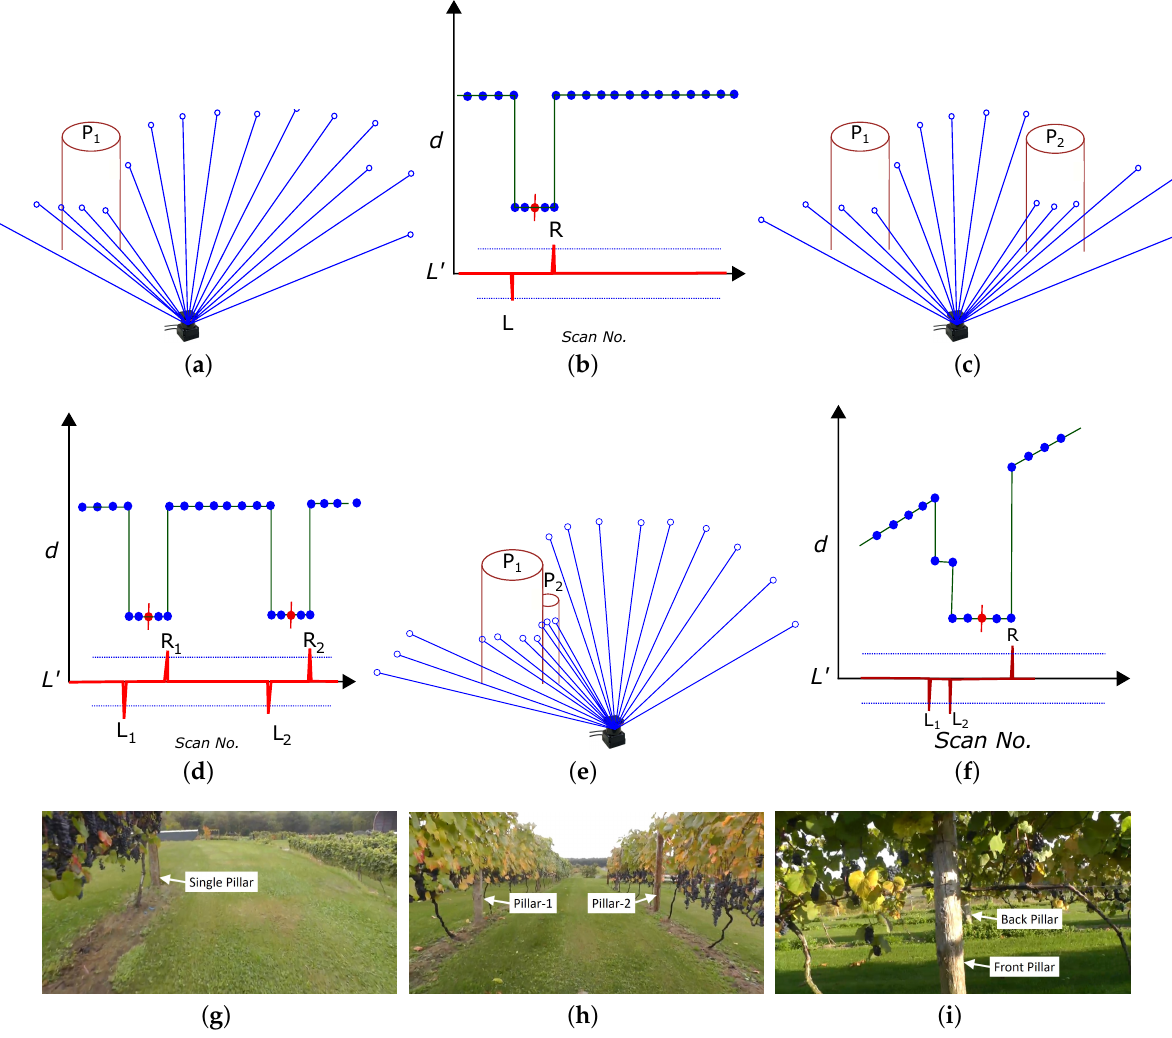
Figure 3. Three different scenarios of pillar detection in a vineyard. The Lidar data and its symmetric derivate are shown on the right. ( a ) Single pillar case. ( b ) Two pillars on either side. ( c ) Occluded pillars. ( g – i ) show the actual pictures of the three scenarios in a